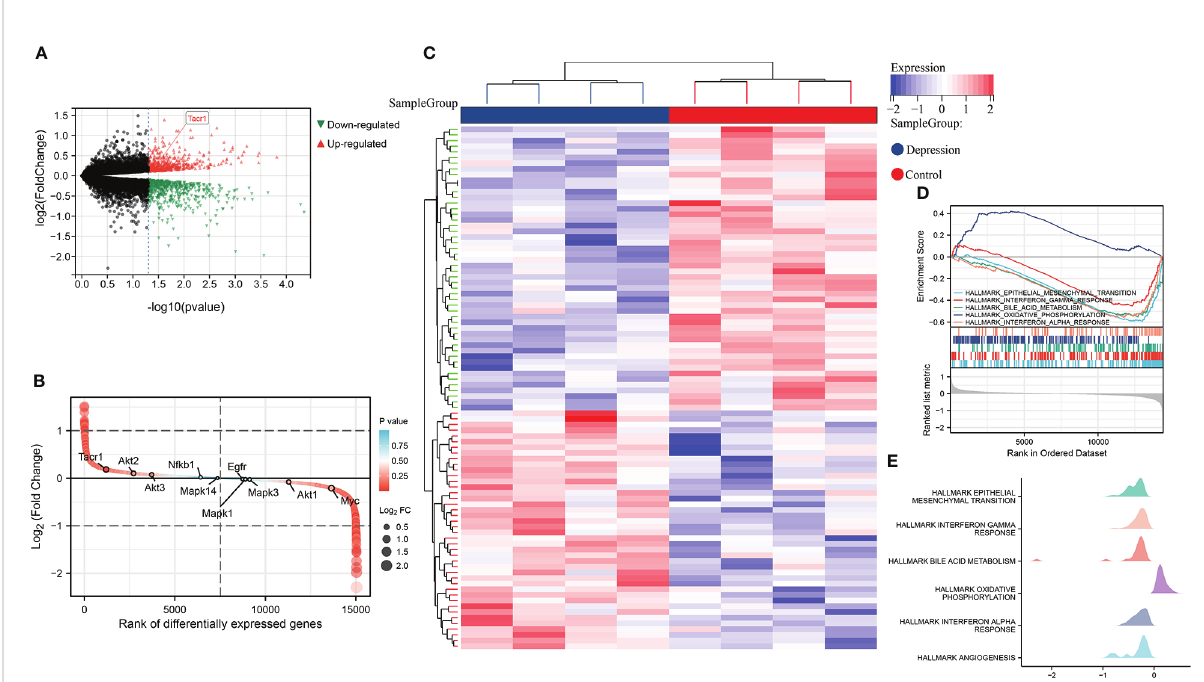
FIGURE 2 (A) Volcano plot of differential expression analysis in GSE198597 dataset. (B) Rank of differentially expressed genes in GSE198597 dataset. (C) Heatmap of differential expression analysis in GSE198597 dataset. (D) Enrichment score and the rank in ordered dataset of GSEA hallmark gene sets in GSE198597 dataset. (E) The distribution of gene expression in signi fi cant hallmark gene sets in GSE198597. X axis represents log2(Fold Change) of enriched